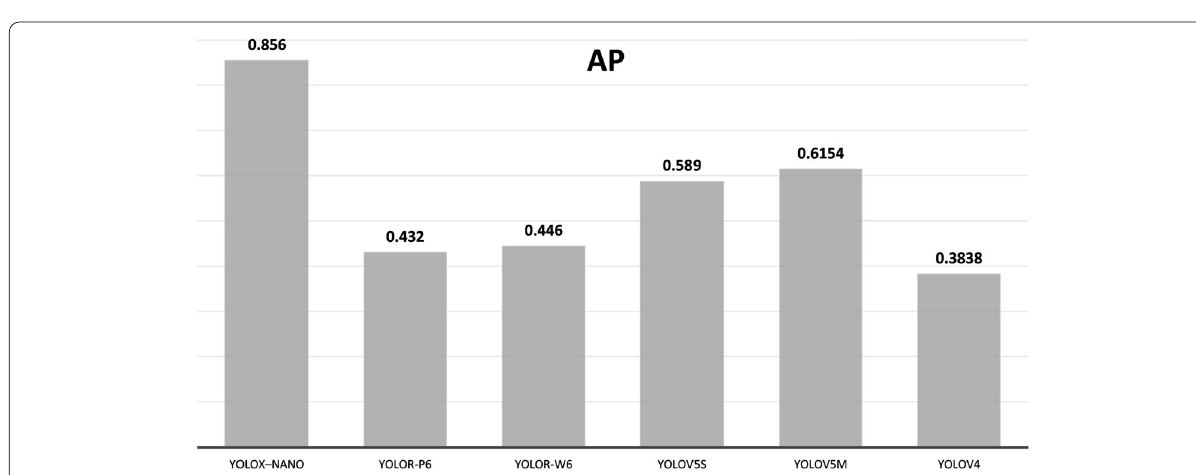
Figure 10 Comparison of mean Average Precision of the different models